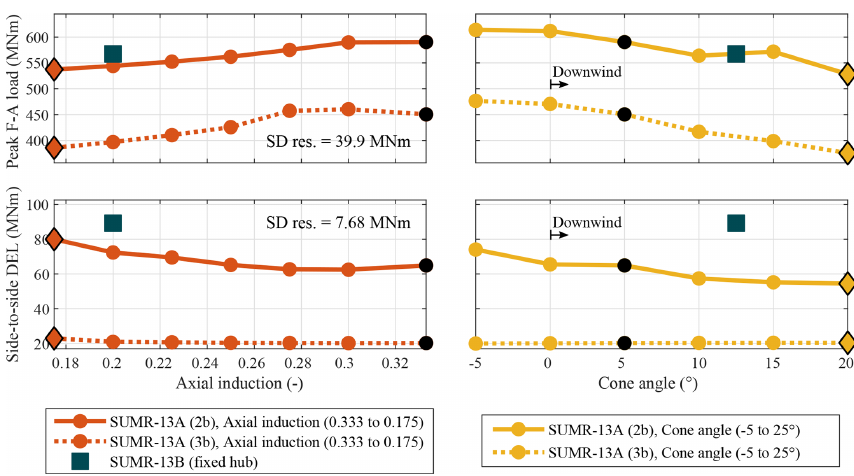
Figure 15. Peak tower loads in the fore–aft (F-A) direction ( m Peak t y ) and side-to-side DELs ( m DEL t x ) for rotors with different axial induction factors (and corresponding blade length changes as discussed in Sect. 8.1; red), cone angles (yellow), and number of blades. The same loads for the SUMR-13B are also shown. Unless otherwise specified, the available rotor power is 13.9MW, the axial induction is 0.333, and the cone angle is 5 ◦ ; the SUMR-13B is specified in Table 1. The standard deviation of the residual for both load axes incorporates all of the presented design